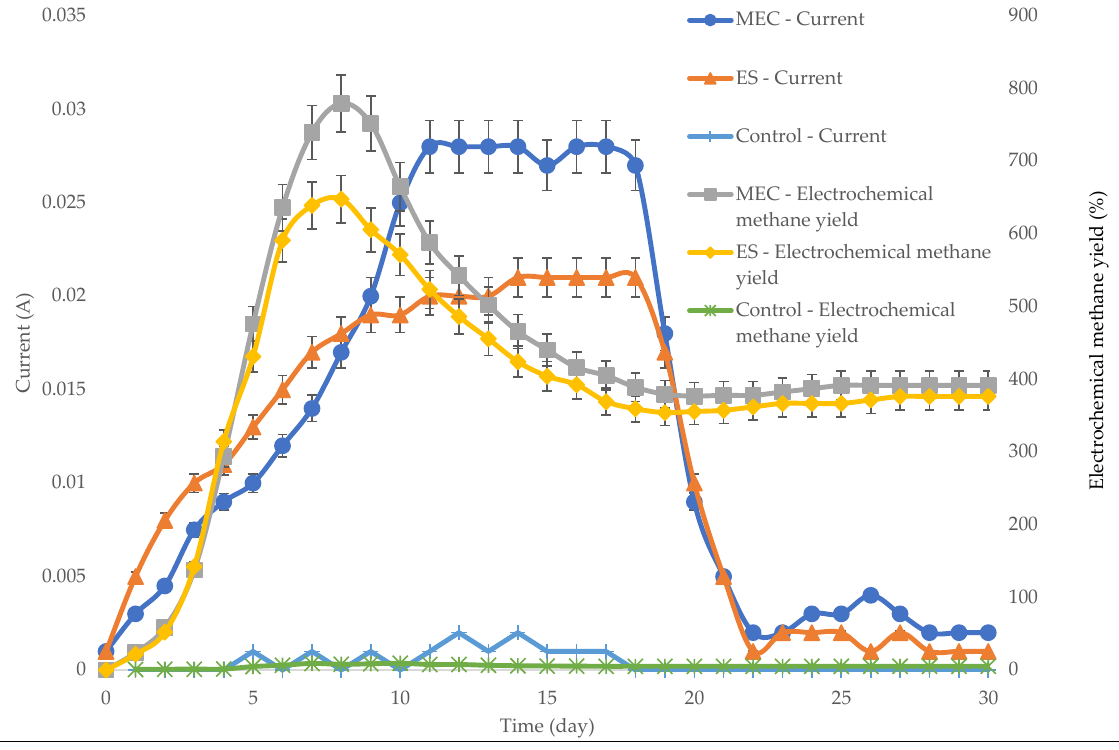
Figure 6. Daily current generation and electrochemical methane yield for the ES and the MEC.